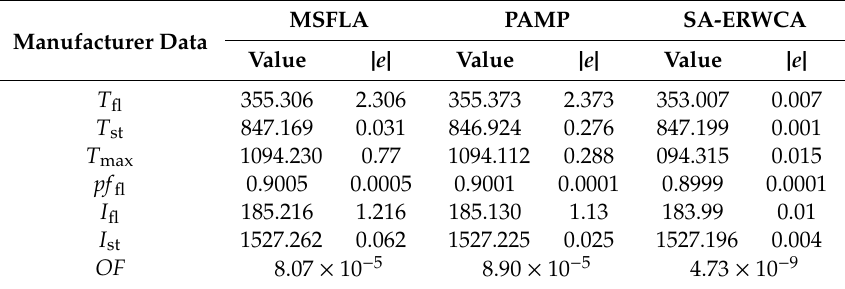
Table 13. Comparison of results with manufacturer data for Machine